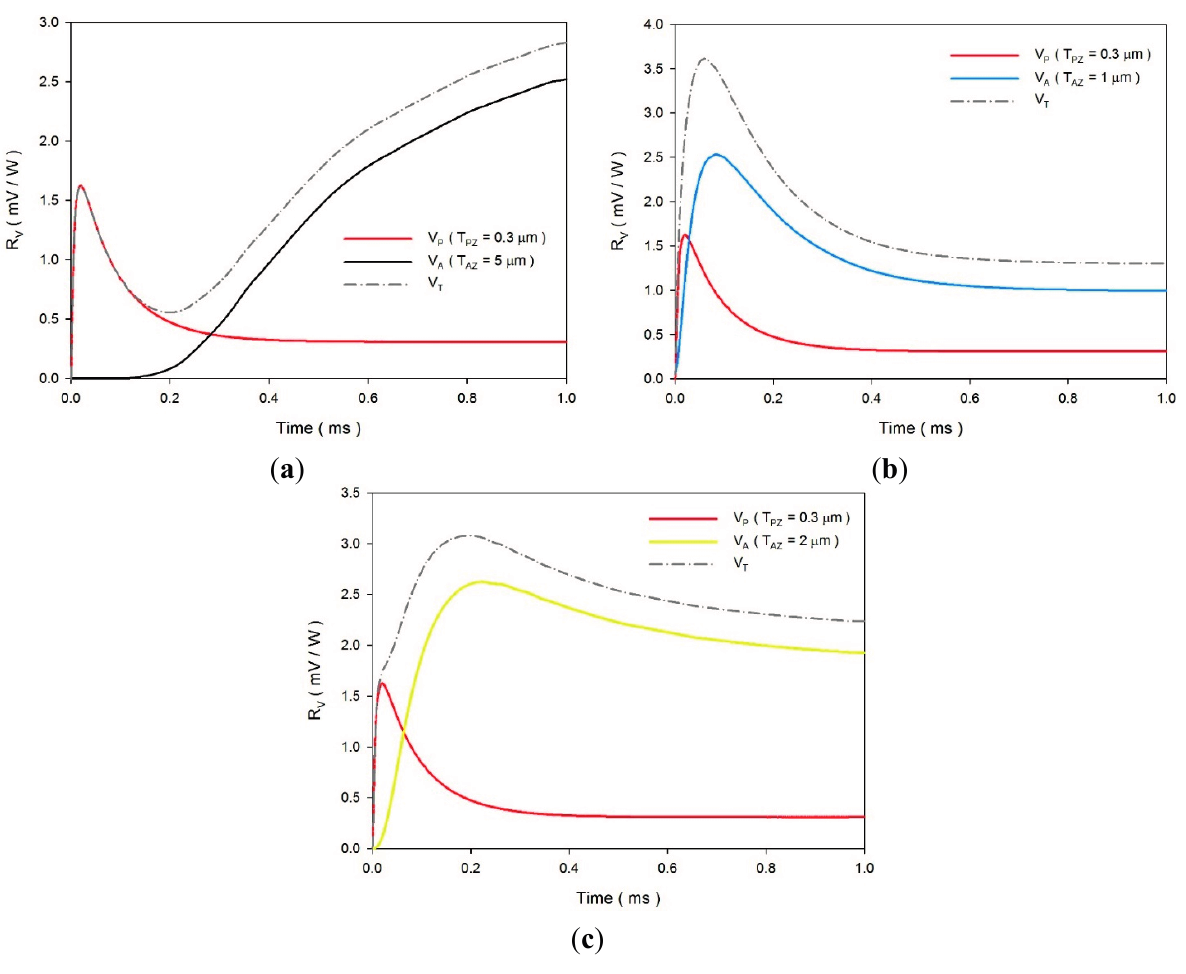
Figure 13. The integrated voltage responsivities (V T ) generated by combining V P , generated by a 0.3 μ m thick sputtered ZnO film, with V A , generated by various thicknesses of